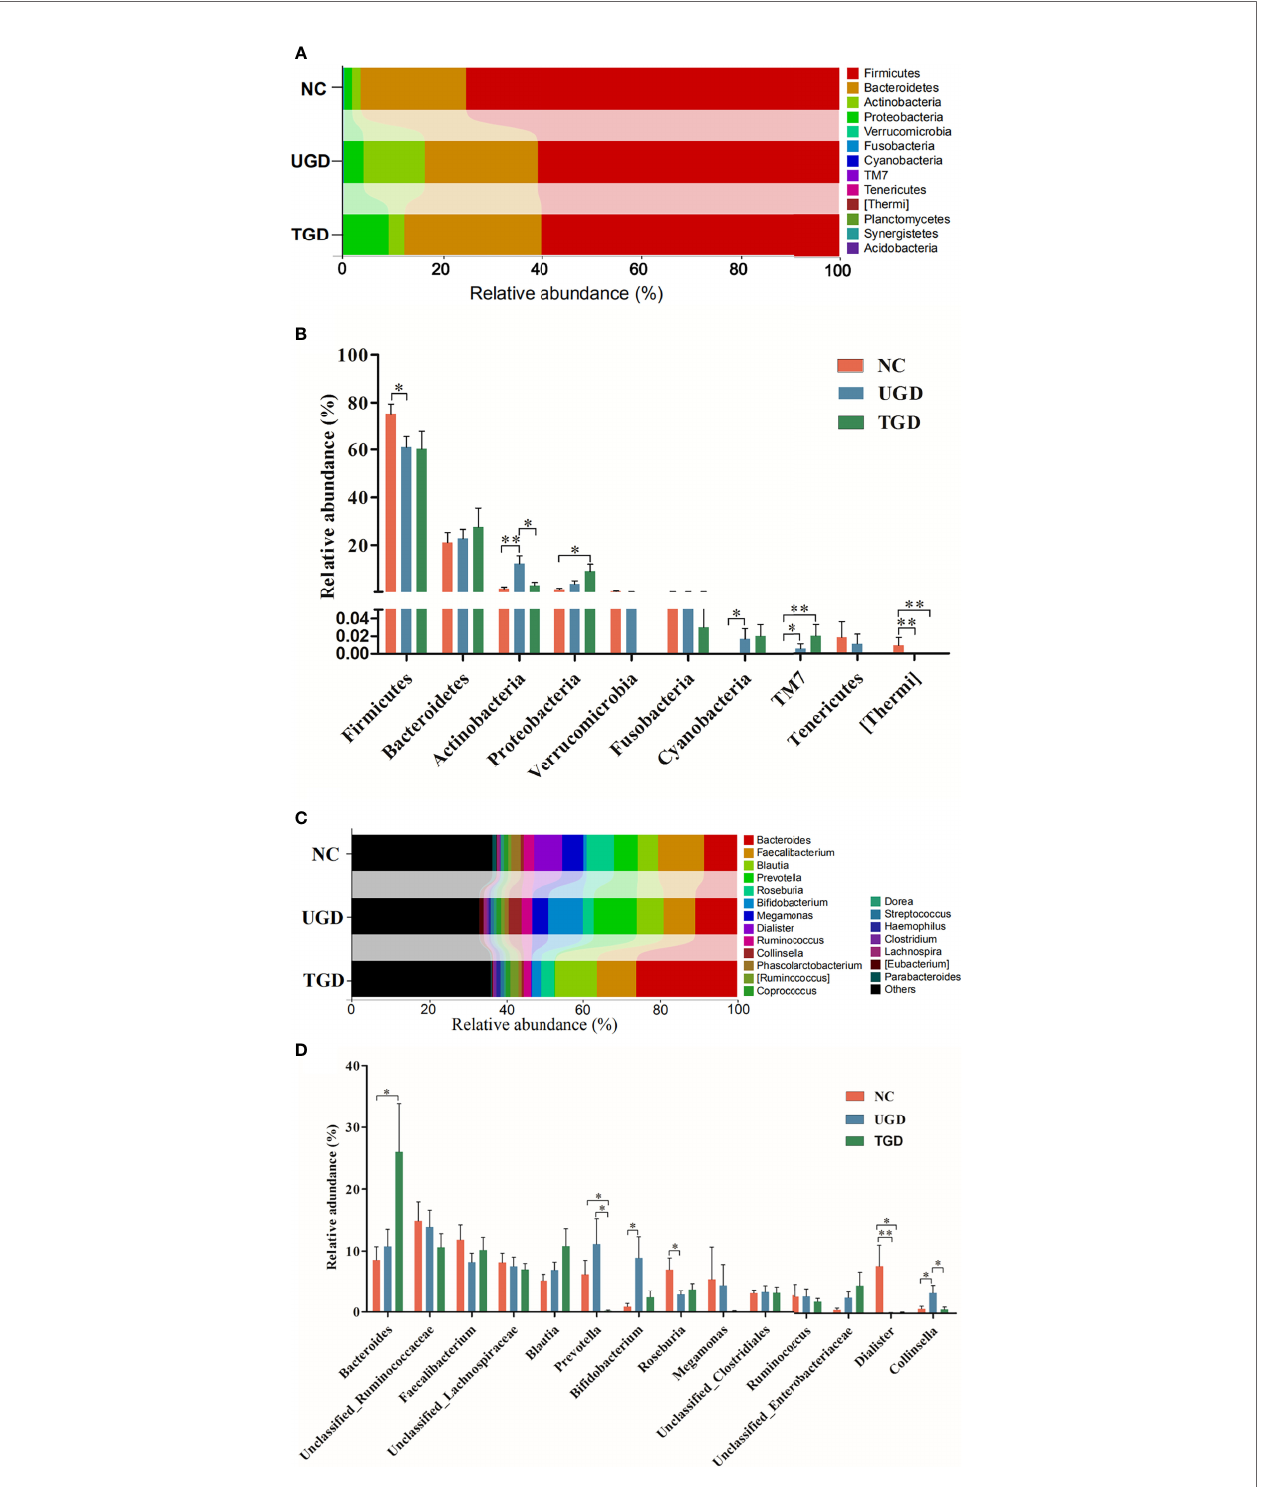
FIGURE 5 | (A) Bar plot of the bacterial community abundance at the phylum level. (B) Signi fi cance of the top 10 bacterial phyla according to community abundance. (C) Bar plot of the bacterial community abundance at the t level. (D) Signi fi cance of the abundance of the top 14 bacterial communities. pairwise comparison among the three groups: * p ≤ 0.017, ** p ≤